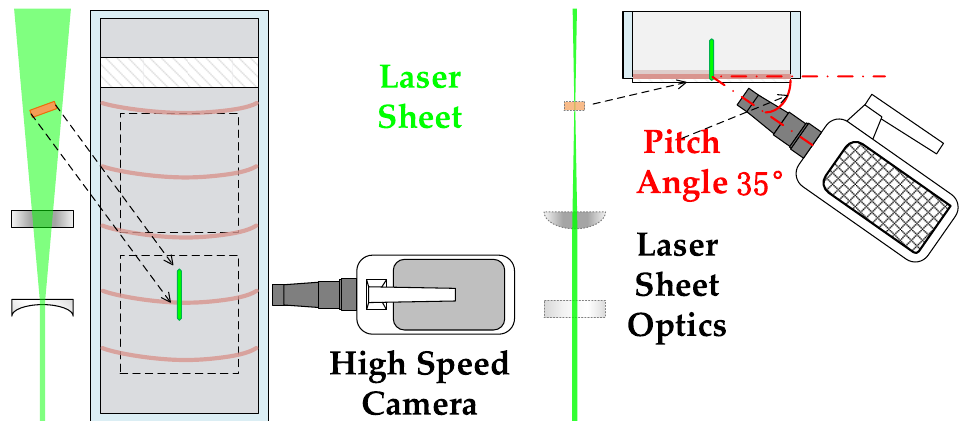
Figure 2. For the film test section, high-speed camera and laser sheet, the high-speed camera is set up beside the test section, as illustrated in the figure. The left part and right part is the same test section of a high speed camera and laser sheet, just being given in different views, in which the left is from the film cross-stream direction, and the right is from the streamwise direction. The high speed camera’s pitch angle against the film spanwise direction is set to 35 degrees.